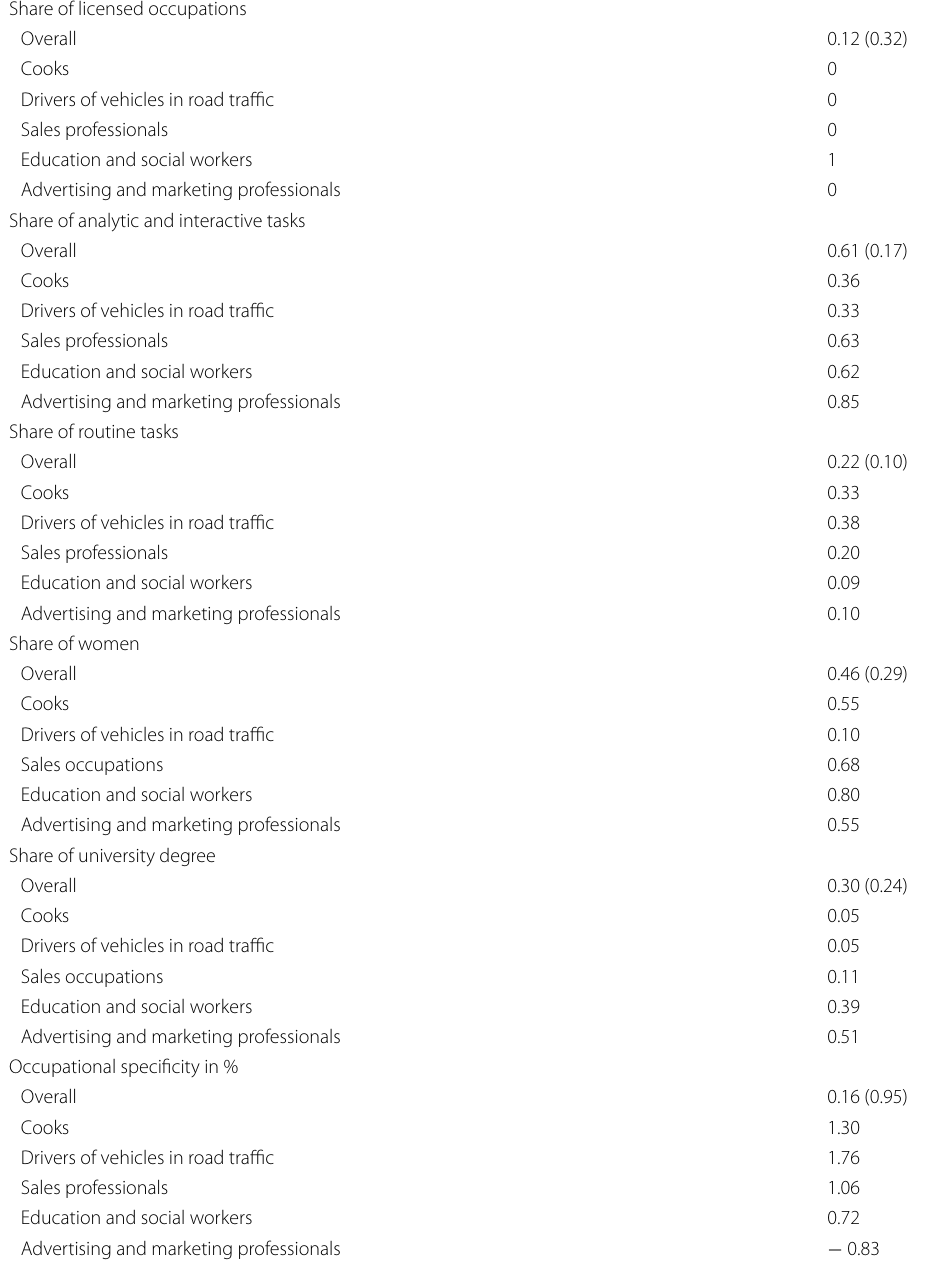
Table 2 Characteristics of selected example occupations and for all analysed 78